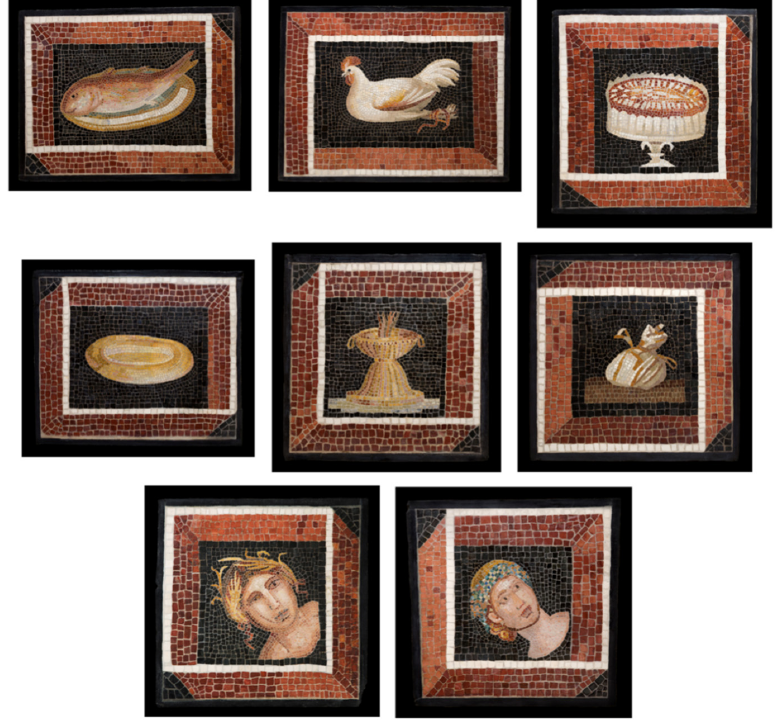
Figure 4. Eight Fragments from a Mosaic Pavement , 2nd century CE. Roman; Rome. Stone, glass, and mortar. Starting from top left: Mosaic Floor Panel Depicting a Fish on a Platter , 28.9 × 36.8 × 6 cm (11